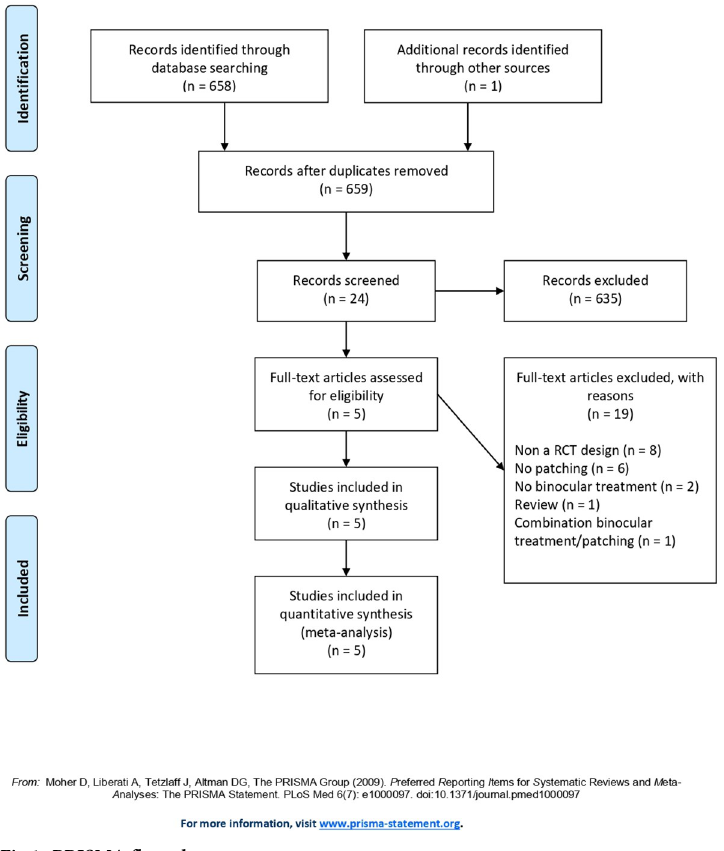
Fig 1. PRISMA flow-chart.